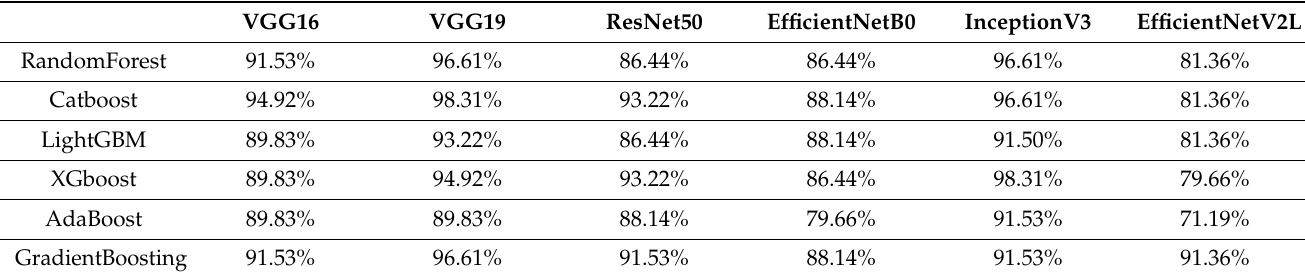
Table A11. Accuracy of each model combination for green